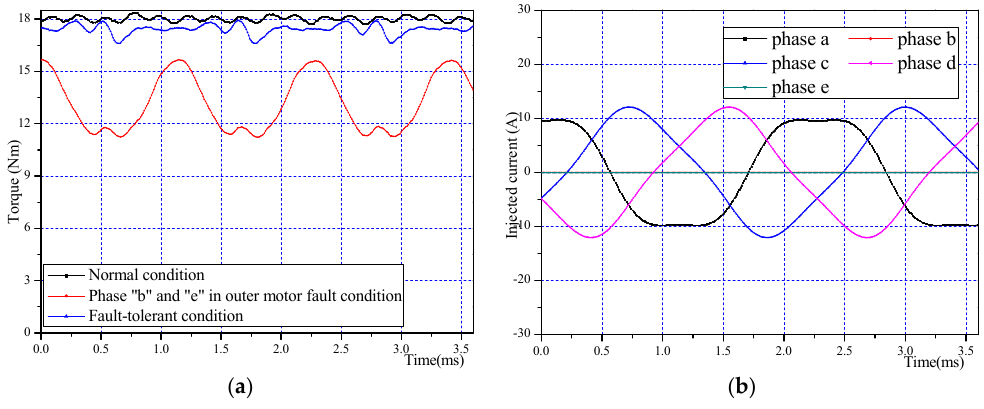
Figure 23. The motor operates under non ‐ adjacent double ‐ phase open circuit in outer motor conditions: ( a ) electromagnetic torque obtained by FEA; ( b ) the injected currents of the outer motor. Torque details (average torque, torque ripple etc. ) of these fault types in Section 3.2 are shown in